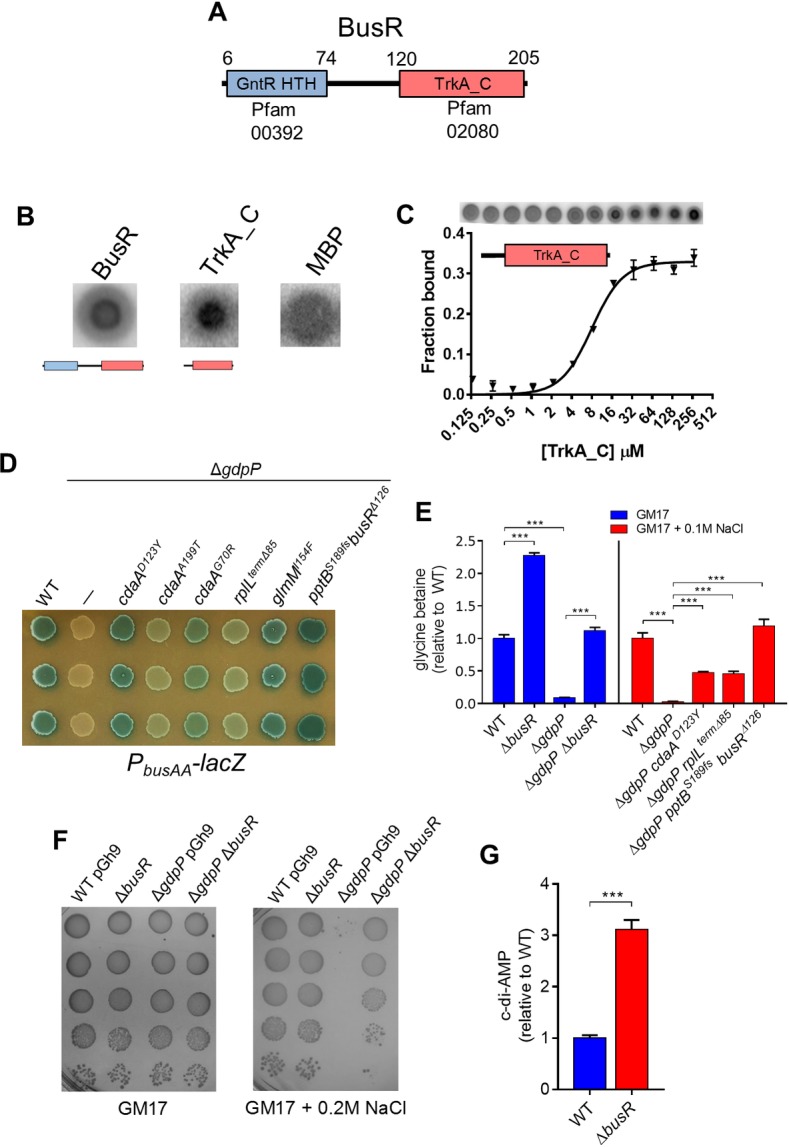
BusR binds c-di-AMP and exacerbates the osmosensitive phenotype of ΔgdpP.(A) Domains in BusR. (B) DRaCALA of cell lysates containing full length BusR, the BusR TrkA_C domain or MBP with 32P-c-di-AMP. (C) DRaCALA and binding affinity of the purified BusR TrkA_C domain with 32P-c-di-AMP. (D) Expression of busAA promoter as a lacZ fusion in different Lc. lactis strains on GM17 agar + 0.1M NaCl. (E) Intracellular glycine betaine levels. Strains in red bars were grown in GM17 + 0.1M NaCl due to the osmoresistant suppressor ΔgdpPcdaAD123Y growing poorly in GM17 alone. Data are the mean ± SEM from three independent biological replications. P < 0.001 (***) indicate significant differences compared to ΔgdpP (one-way ANOVA followed by Tukey’s test). (F) Comparison of growth of strains on GM17 agar or GM17 agar + 0.2M NaCl following spotting of serial dilutions. (G) C-di-AMP levels in WT Lc. lactis and ΔbusR. Data are the mean ± SEM from three independent biological replications. Significant results P < 0.001 (***) are indicated (Student’s t test).